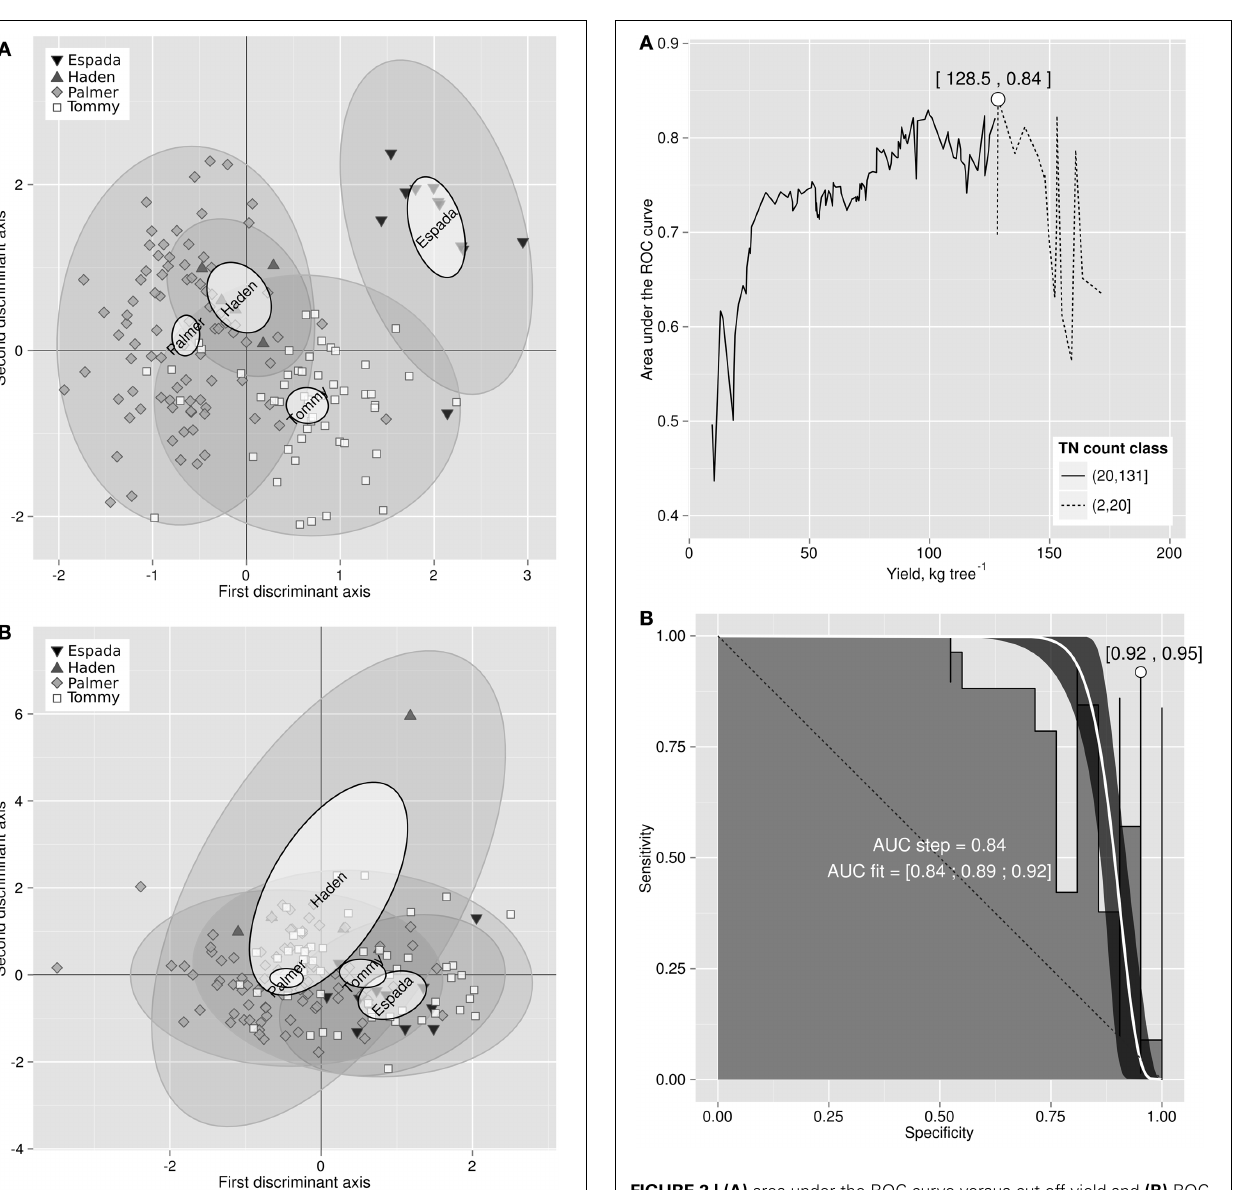
FIGURE 2 | (A) area under the ROC curve versus cut-off yield and (B) ROC curve for yield cut-off of 128.5kg fruit tree − 1 . PAN BALANCE